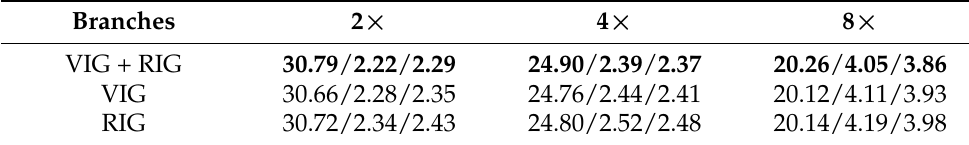
Table 2. Analysis of the learnable branches. The best performance is highlighted.